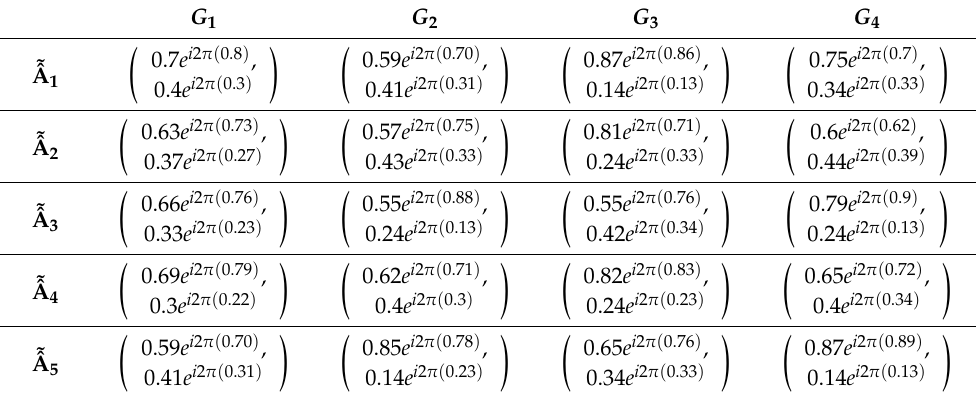
Table 9. Decision matrix for Example